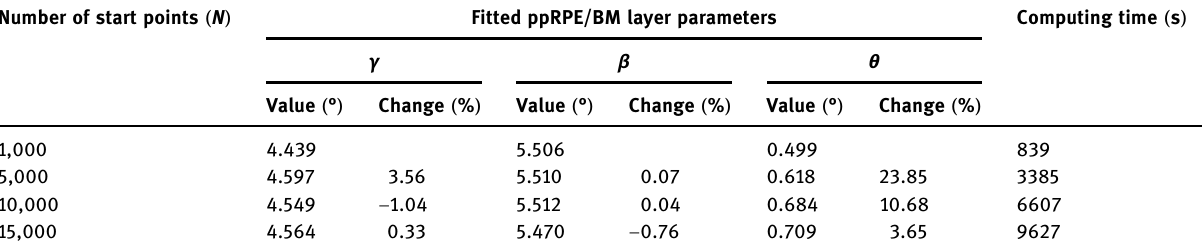
Number of start points ( N